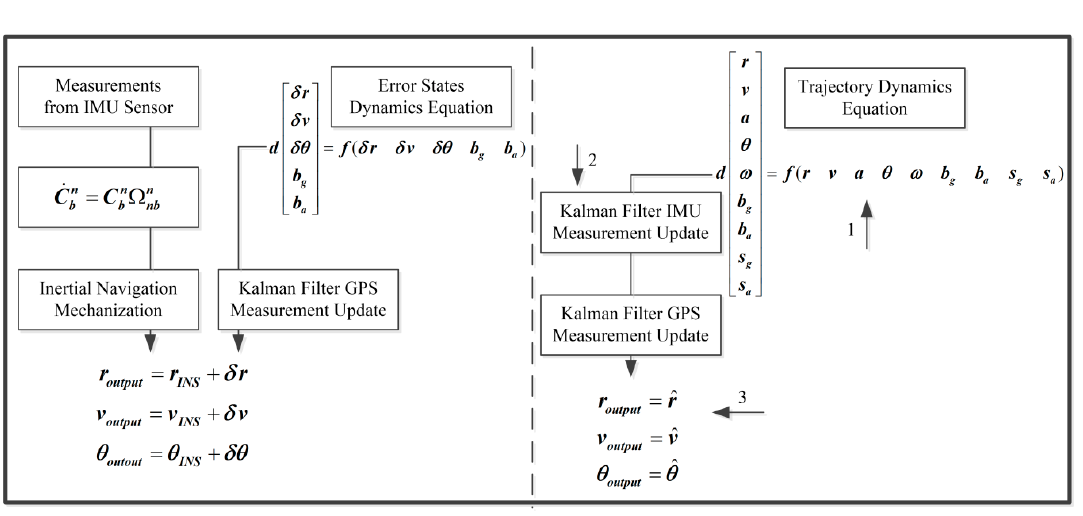
Figure 6. Comparison with conventional global positioning system (GPS)-aided IMU integration mechanism.